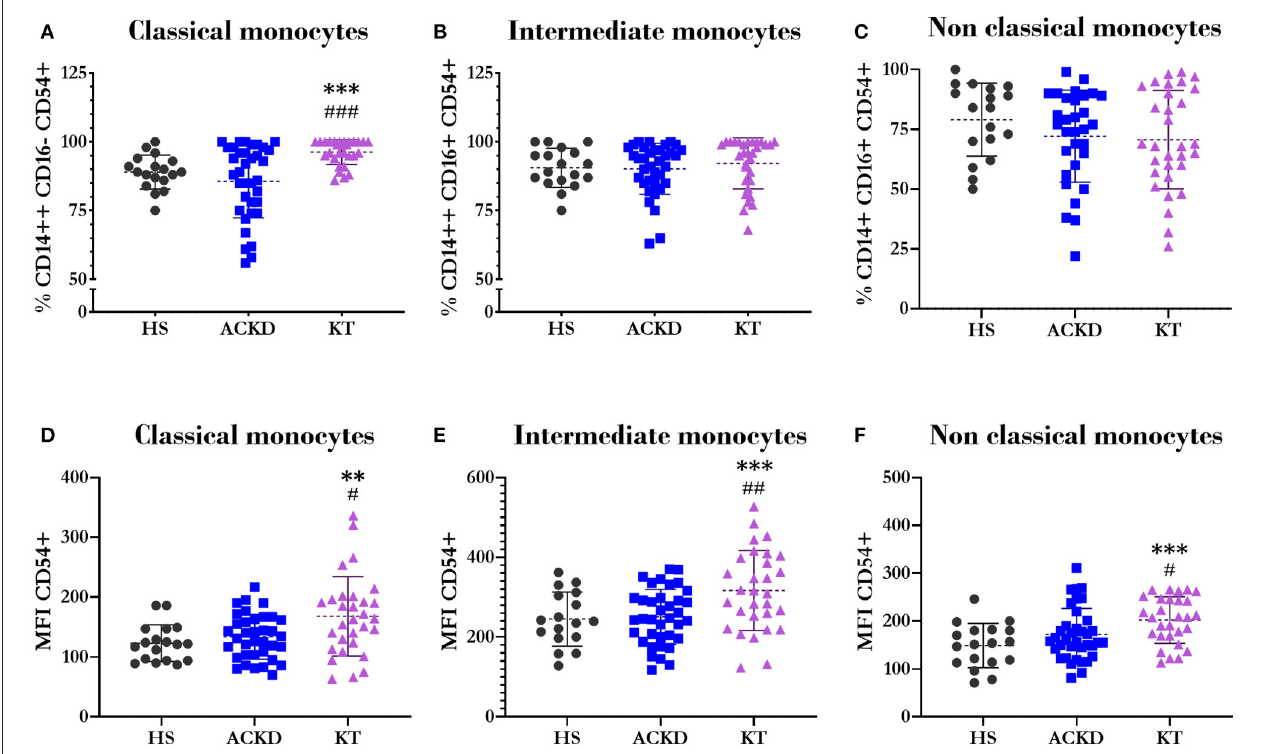
FIGURE 7 | Expression of CD54/ICAM1 in different monocyte subsets. Percentage of classical Ω (A) (CD14 ++ CD16 − ), intermediate Ψ (B) (CD14 ++ CD16 + ), and non-classical Ψ (C) (CD14 + CD16 + ) monocytes expressing CD54. Mean fluorescence intensity of CD54 in classical Ω (D) (CD14 ++ CD16 − ), intermediate Ψ (E) (CD14 ++ CD16 + ), and non-classical Ψ (F) (CD14 + CD16 + ) monocytes in healthy subjects (HS), patients with advanced chronic kidney disease (ACKD), and patients with kidney transplantation (KT). ** p ≤ 0.01, *** p ≤ 0.001 vs. HS; # p ≤ 0.05, ## p ≤ 0.01, ### p ≤ 0.001 vs. ACKD. Statistical analysis: Ψ ANOVA (Tukey test). Ω ANOVA (Games-Howell test). ANOVA, analysis of